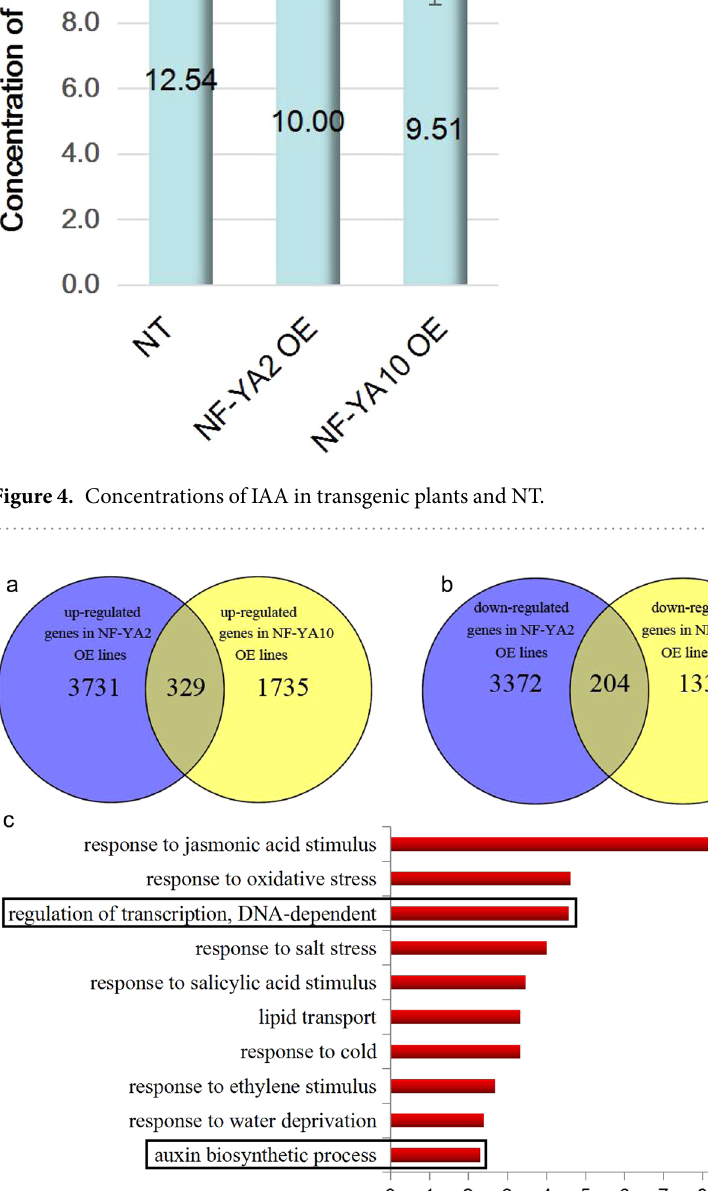
(Supplementary Table S1). Together, functional characterization of DEGs between NF-YA2 OE line and NF-YA10 OE line indicated that NF-YA2 (10) maybe regulate auxin biosynthesis via YUCCA family genes.